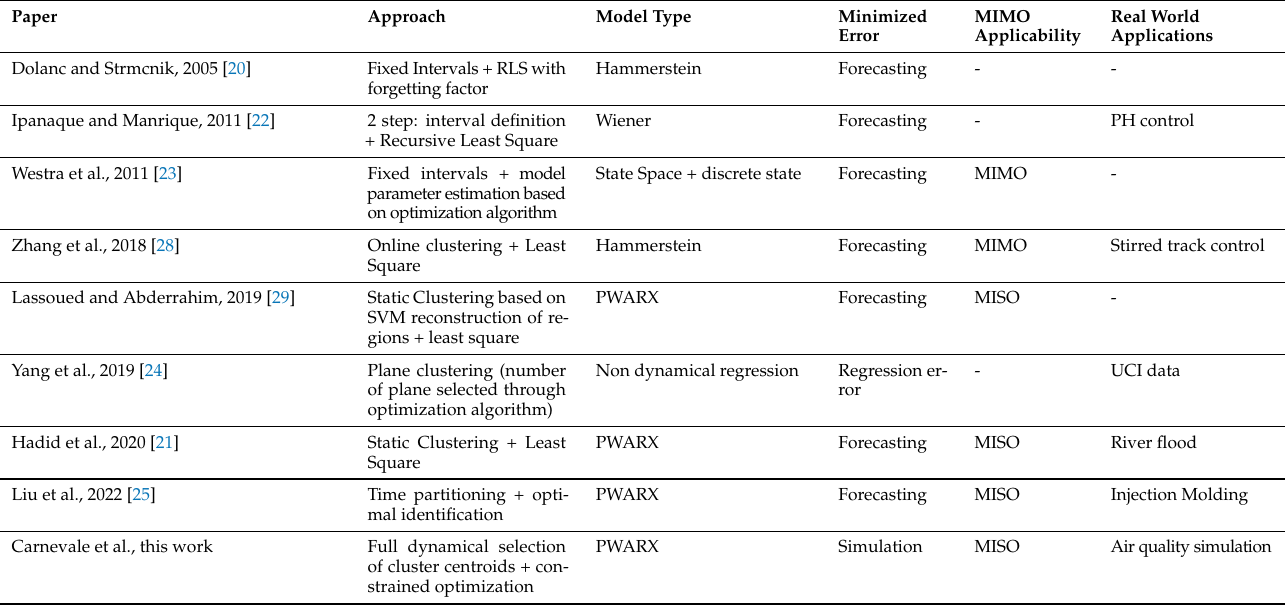
Table 1. Comparison of this paper with related literature